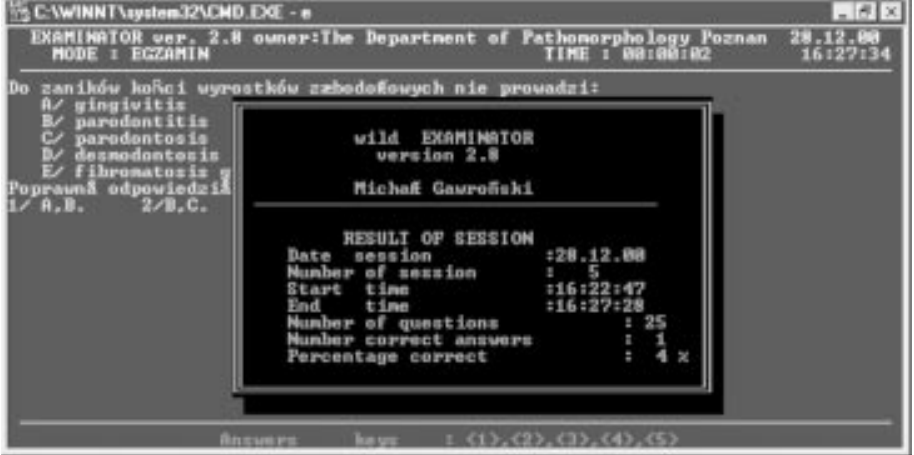
Fig. 5. Display of summary of final result at the examination